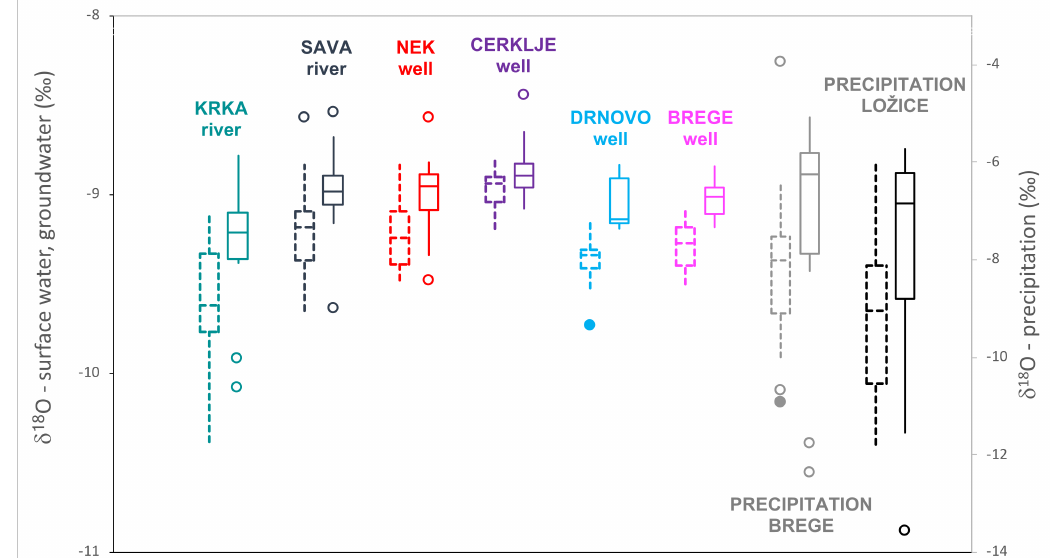
Figure 7. Distribution of δ 18 O with upper and lower quartile, median, and outside values in precipi- tation, surface water, and groundwater sampled before (dashed line) and after (solid line) the filling of the accumulation basin for the HPP